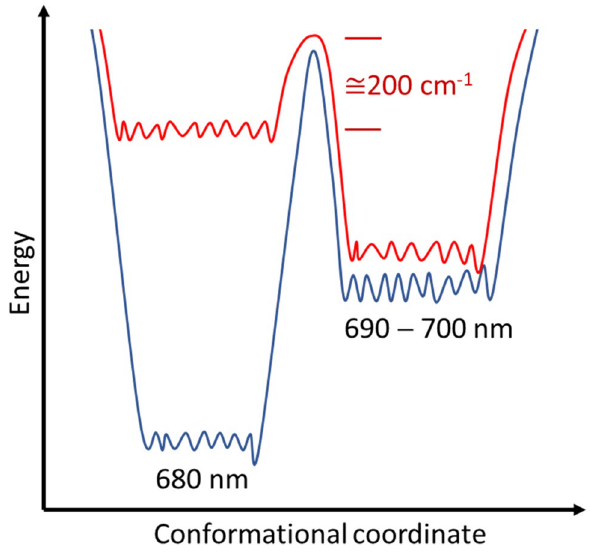
Figure 6. Schematic sketch of the highest tier of the protein energy landscape of the SCP protein structure. For the fresh samples (blue line) the states emitting around 680 nm and around 690–700 nm are separated by a high energy barrier. For the 7 months old samples (red line) the barrier height is lowered such that the available thermal energy at room temperature is sufficient to overcome this